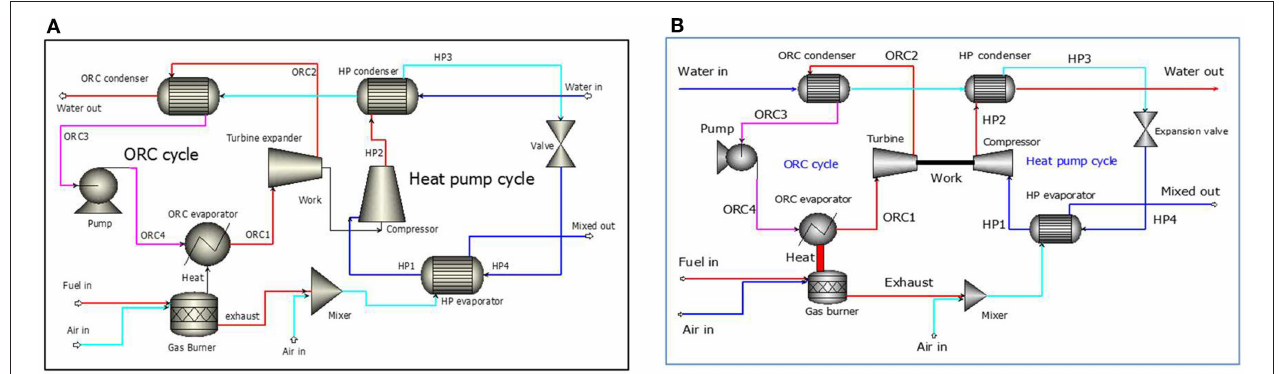
FIGURE 1 | Schematic diagram of two designs. (A) The first design of the combined system. (B) The second design of the combined system.